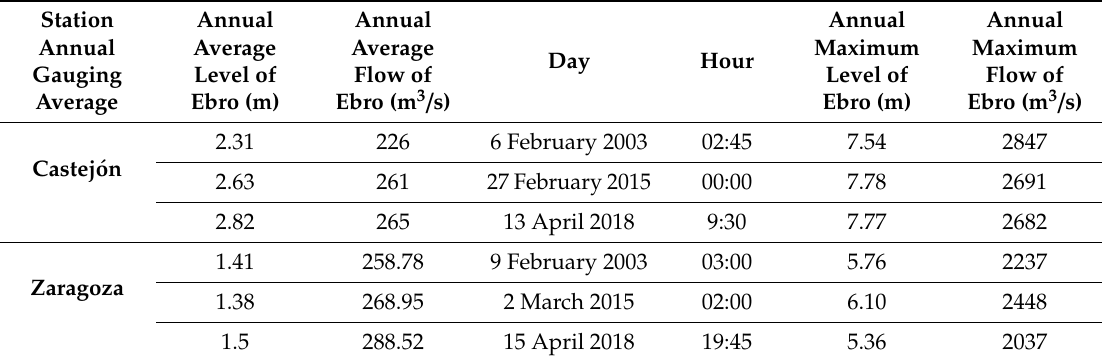
Table 1. Representative values on the annual levels and flows of the Ebro river in two gauging stations, Castej ó n and Zaragoza, in its course for the years 2003, 2015, and 2018. Historical data taken from the SAIH of the CHE,